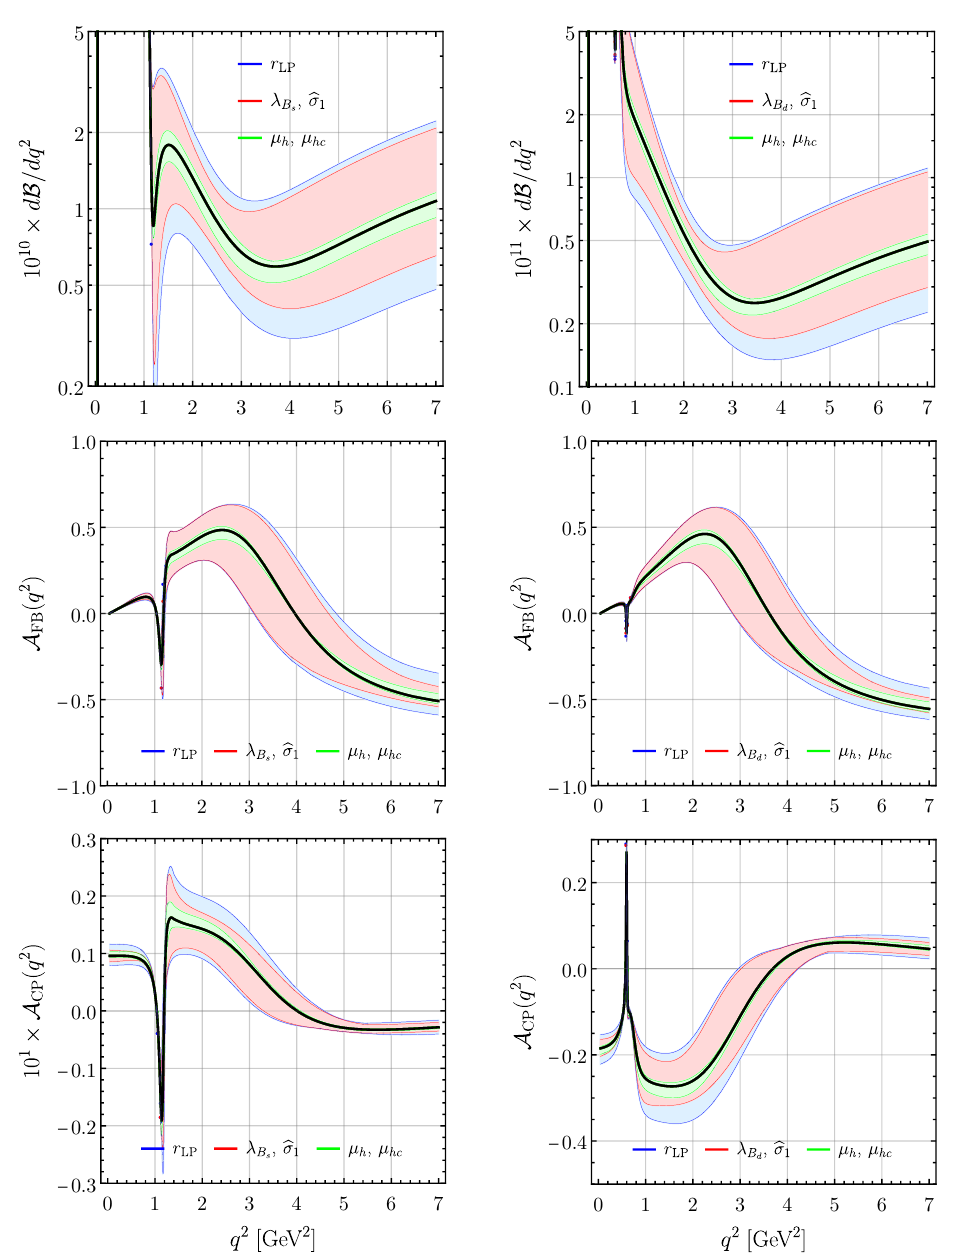
Figure 10 . Uncertainty budget for d B /dq 2 [upper], A FB ( q 2 ) [middle] and A CP ( q 2 ) [lower] for q = s [left] and q = d [right] when adding successively in quadrature the uncertainties due to renormaliza- tion scales ( µ h,hc ) [green], B -meson LCDA parameters ( λ B ( r LP )